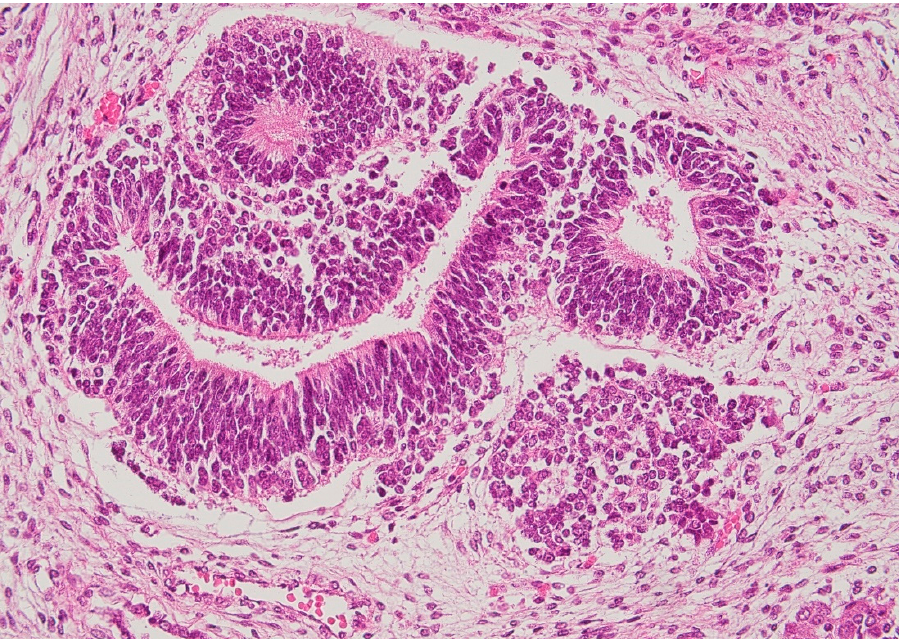
Figure 4. Histology of mature components of the neoplasia: endodermal elements with respiratory cilitaed epithelium (blue arrow) and glands (top right of the picture). Cartilage (mesoderm) was also present (star). (Hematoxylin Eosin (HE) staining 10×).